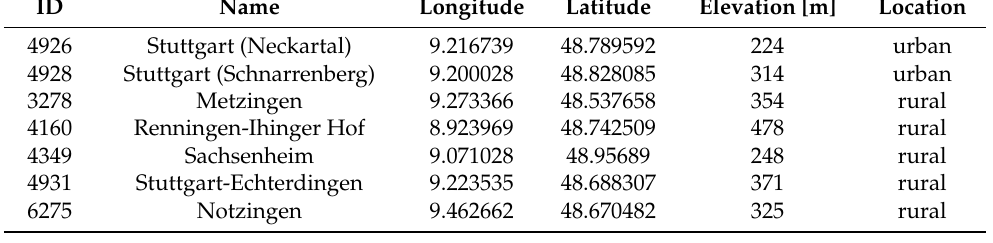
Table A2. Overview of all stations of the german weather service (DWD) used in this study with their names, ID numbers, and location.